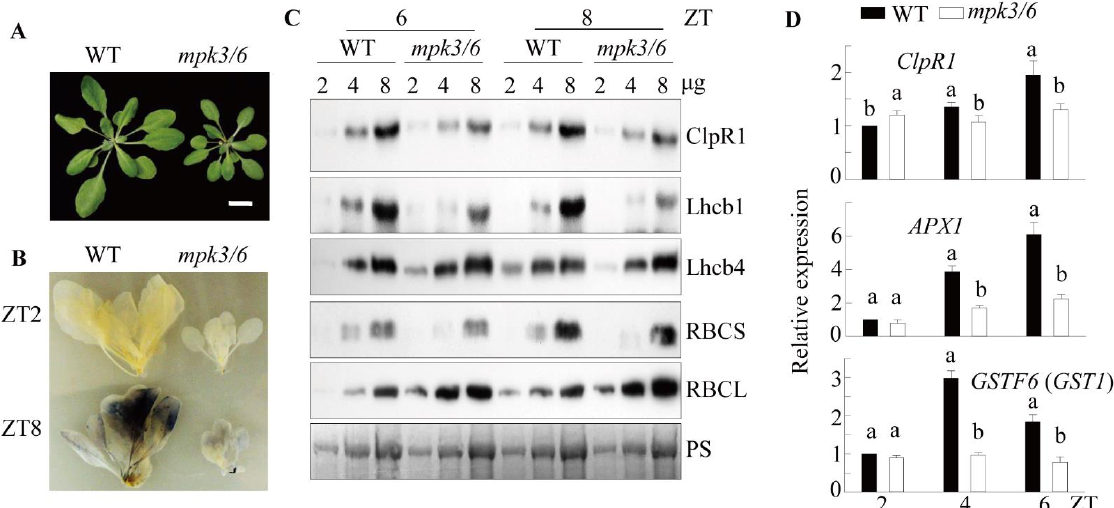
Figure 7. ( A ) Rosette phenotype of WT (Col-0) and mpk3/6 -double knockdown plants. Plants were grown for four weeks under a light intensity of 50 μmol m -2 s -1 . ( B ) Leaf starch contents of the WT (Col-0) and mpk3/6 lines. Plants were collected at ZT2 or ZT8. ( C ) Western blot analysis using anti-ClpR1, -Lhcb1, -Lhcb4, -RBCS, and -RBCL antibodies, as described in Figure 3. Plants were collected at ZT6 or ZT8. ( D ) Diurnal expression of ClpR1 , APX1 , and GST1 at ZT2, ZT4, and ZT6. Scale bar: 1 cm. Different letters indicate significant differences (Tukey’s post hoc HSD test; p < 0.05).